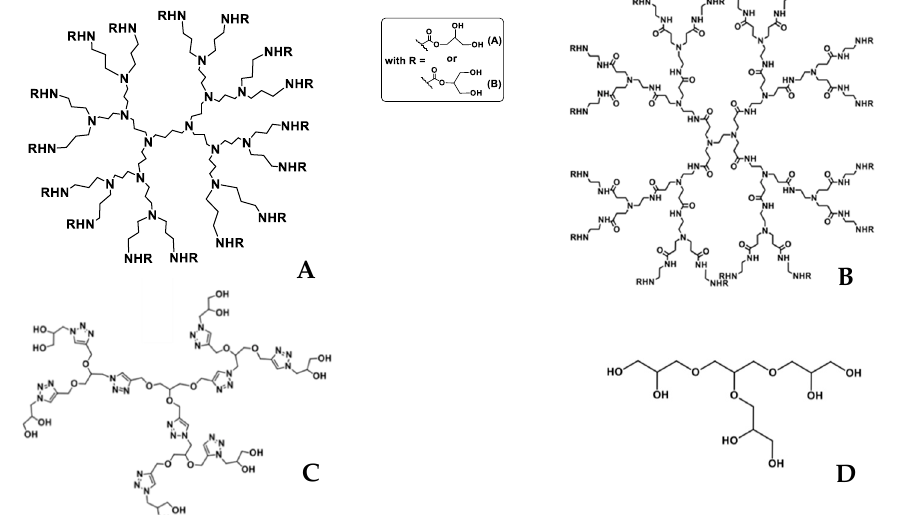
Figure 1. Structures of dendrimers: ( A ) Glycerodendrimers polypropylenimine 3rd generation (GD-PPI-3). ( B ) Glycerodendrimers polyamidoamine 2nd generation (GD-PAMAM). ( C ) Glyceroclikdendrimers 2nd generation (GCD-2). ( D ) Glyceroladendrimers 1st generation (GAD).